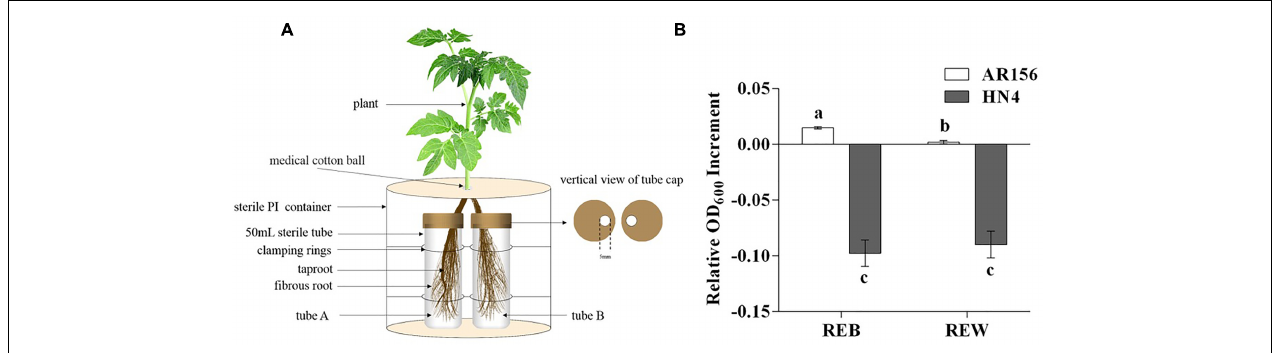
FIGURE 1 | Tomato root exudates collection and effects on relative growth increment of Bacillus cereus AR156 and Ralstonia solanacearum HN4. (A) Tomato root exudates were collected in a split-root system. Root bundle in tube A was inoculated with water or cell culture of B. cereus AR156, and root exudates was collected in tube B with spatial separation from potential interference of B. cereus AR156 metabolite. (B) Relative growth increment of Bacillus cereus AR156 and Ralstonia solanacearum HN4 in minimal medium containing different root exudates. Tomato root exudate induced by Bacillus cereus AR156 (1 × 10 7 CFU/mL) (REB); Tomato root exudate induced by sterile water (REW). The mean and standard error values of three biological replicates are reported for each treatment. Different letters within a column indicate significantly differences among treatments according to the Duncan’s multiple range tests test ( P < 0.05). The experiment was carried out three times and one representative experiment is